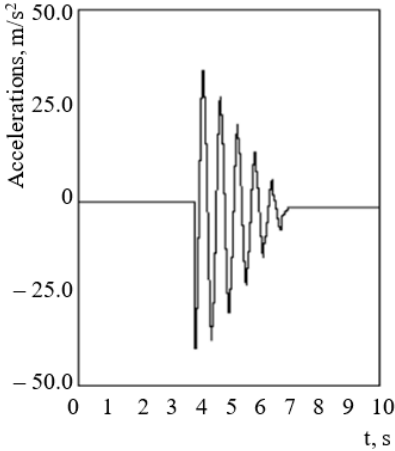
Figure 7. Accelerations to a container in the longitudinal plane.